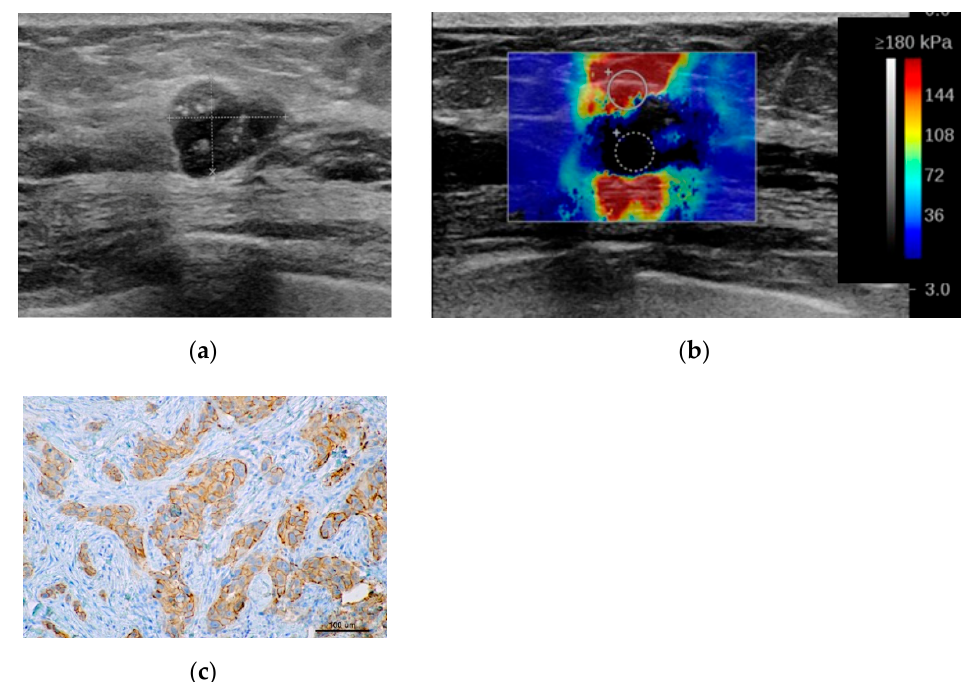
Figure 5. Typical HER2+ tumor. ( a ) B-mode shows posterior enhancement and calcifications. ( b ) On shear wave elastography (SWE) increased stiffness is visible, Emax 300 kPa. ( c ) IHC HER2(2+) membrane staining (magnification 10 × ). HER2+ = human epidermal growth factor receptor 2 positive; IHC = immunohistochemistry.